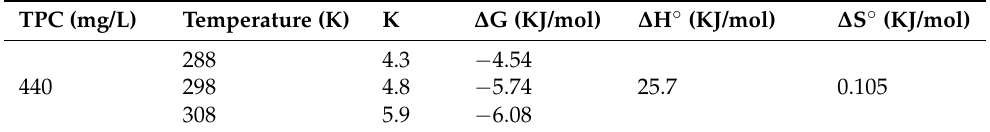
Figure 3. The temperature effect on the TPC removal using a 2% adsorbent dose, pH 4.0, and initial TPC 440 mg/L. Table 3. Thermodynamic parameters estimated at different